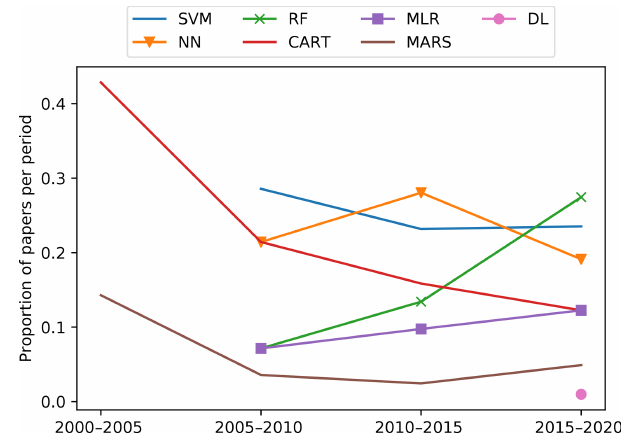
Figure 6. Number of articles published under paid and open access.